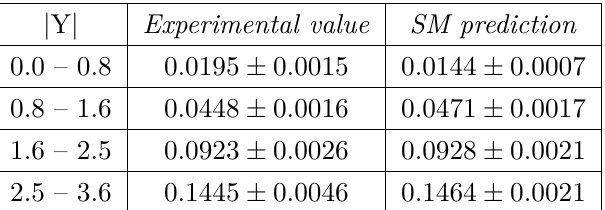
√ s = 8 TeV data for a dilepton